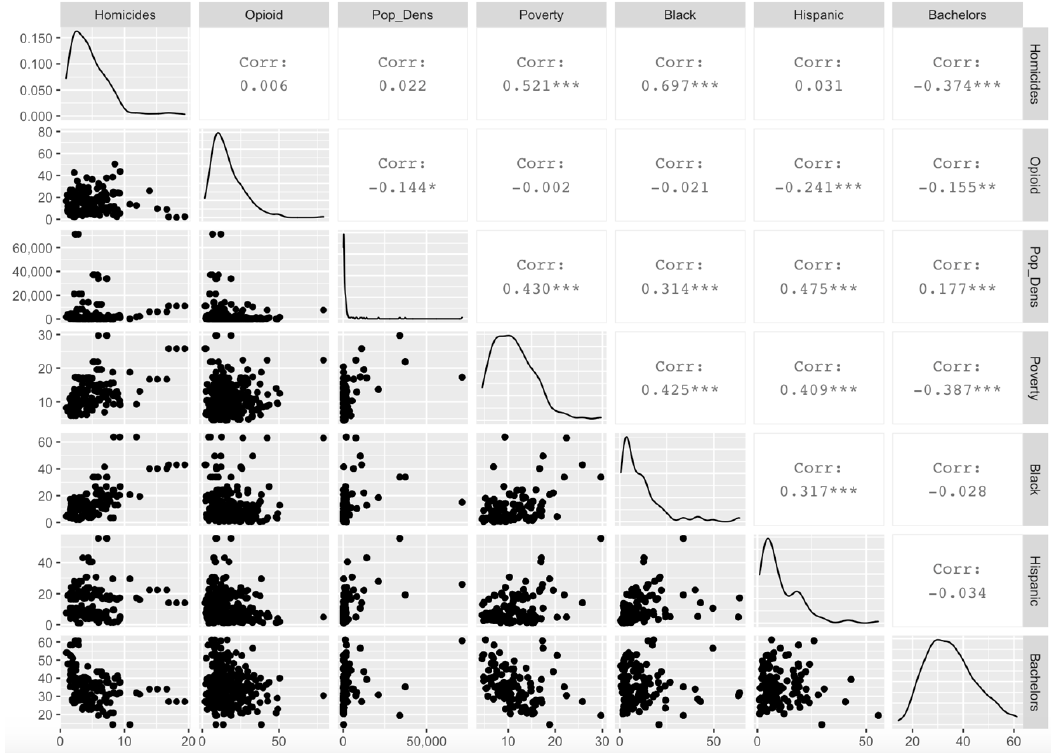
Figure A3. Cross-correlations between explanatory variables for urban counties. * Indicates statistically significant correlation between the corresponding variables, * <0.05, ** <0.01, *** <0.001.